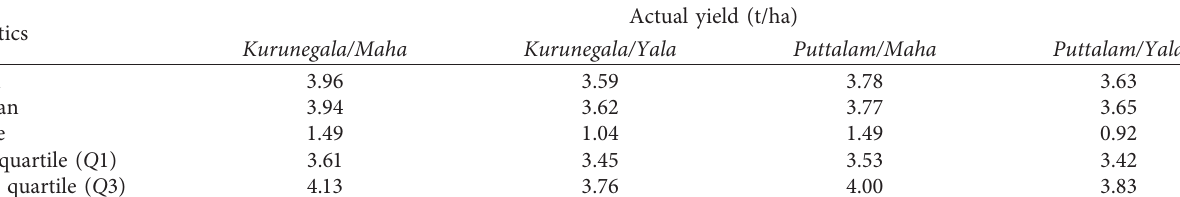
Table 1: Summary of the statistics of rice yield data.